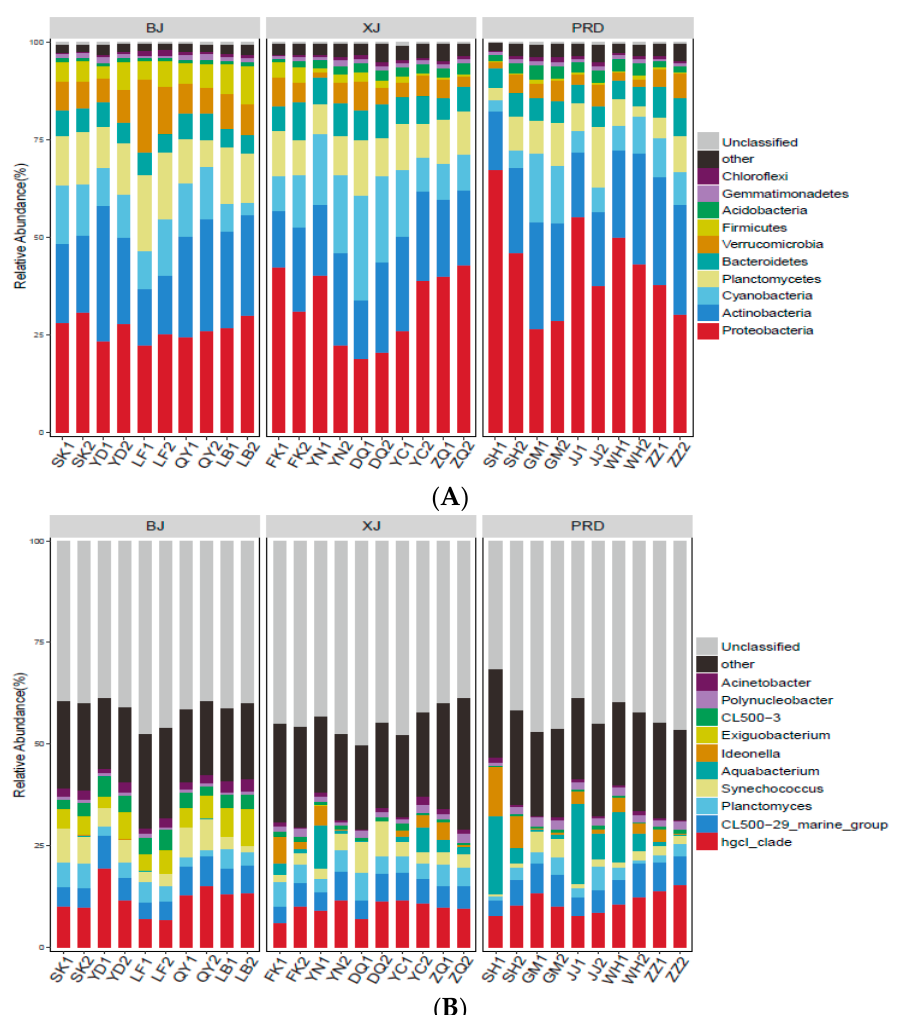
Figure 3. Composition of bacterioplankton community at the phylum ( A ) and genus levels ( B ) across all samples. Only the top 10 taxa with the largest mean relative abundance are shown. BJ, Beijiang; XJ, Xijiang; and PRD, Pearl River Delta.